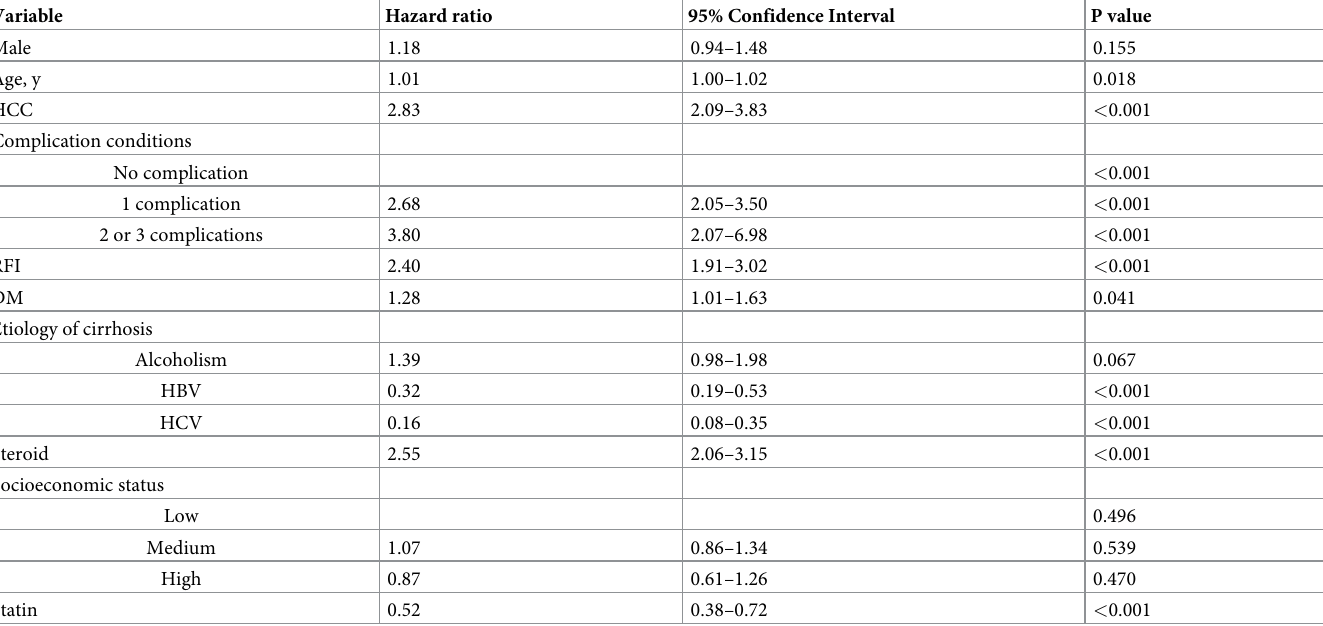
Table 2. Adjusted hazard ratios of risk factor for 30-day mortality of cirrhotic patients with bacterial infections.